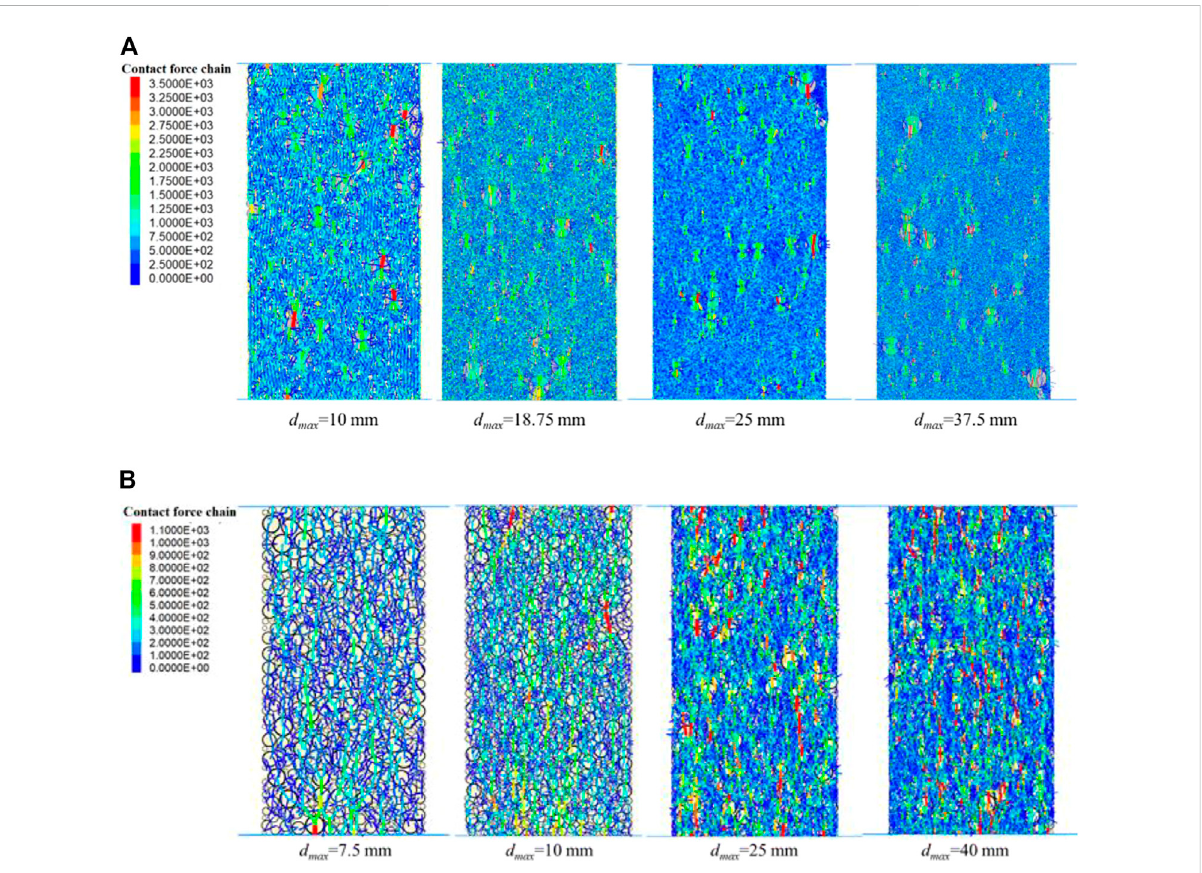
FIGURE 7 Force chain distributions of the S-RM sample with different d max values with (A) 20%; (B) 90% VBP at the peak stress